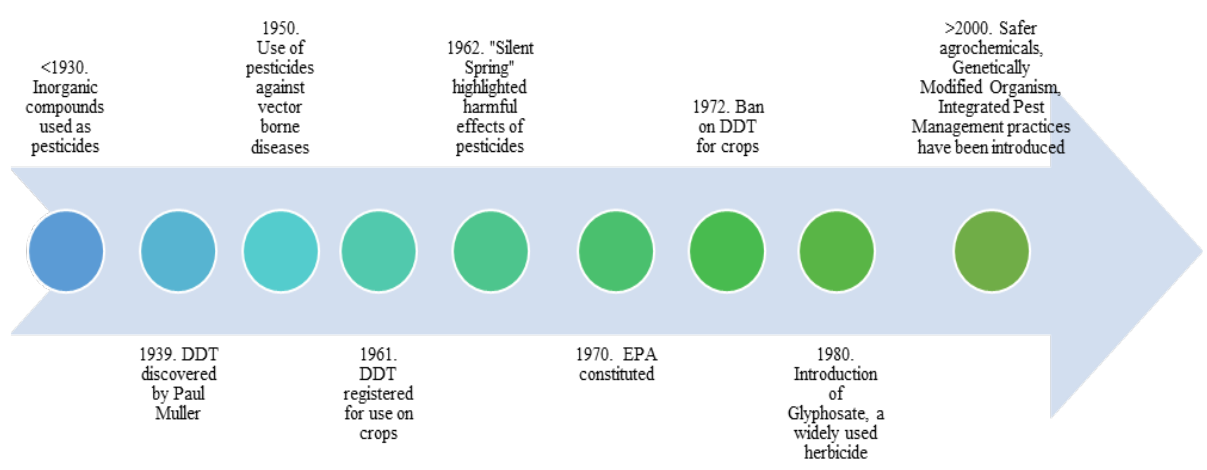
Figure 1. A timeline of pesticide uses since early 1930s.